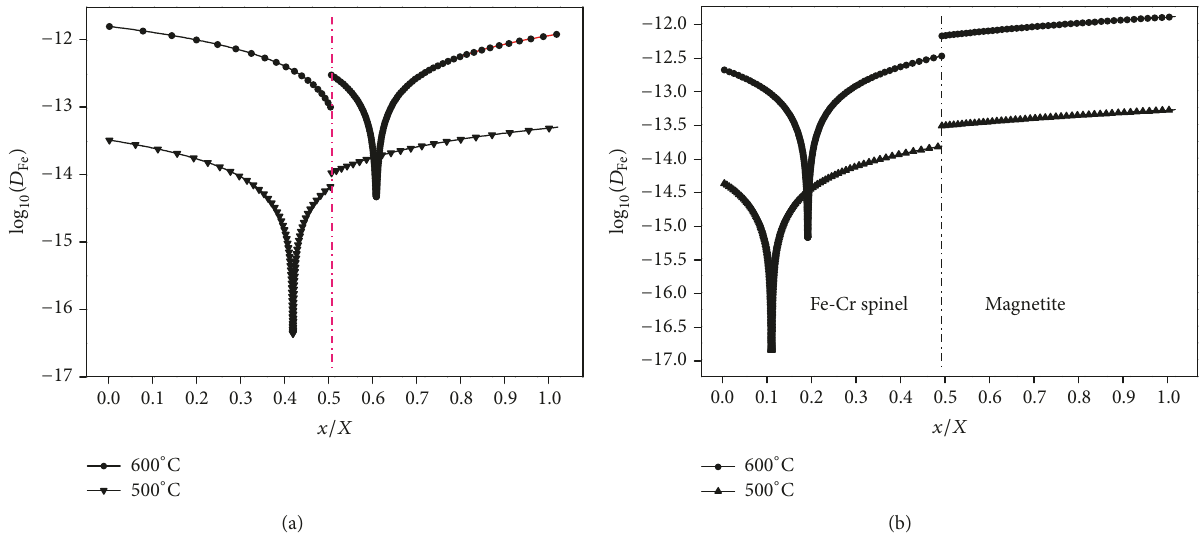
Figure 6: The diffusion coefficient of iron in the duplex scale formed on NF616 (a) and HCM12A (b) as a function of the normalized